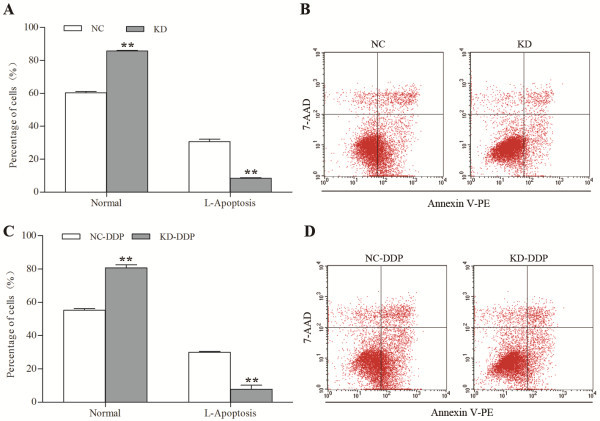
Effect of H19 knockdown on the apoptosis of JAR cells. A. Comparison of the percentages of normal cells and early apoptotic cells between the NC group and the KD group. H19 knockdown significantly increased the percentage of normal cells but decreased the percentage of early apoptotic cells when compared with the NC group; B. Flow cytometric analysis of JAR cells in the NC group and the KD group; C. Comparison of the percentages of normal cells and early apoptotic cells between the two groups with DDP treatment. H19 knockdown also significantly increased the percentage of normal cells but decreased the percentage of early apoptotic cells when compared with the NC-DDP group; D. Flow cytometric analysis of JAR cells in the NC-DDP group and the KD-DDP group. NC-DDP is the negative control vector-harboring cells incubated with DDP; KD-DDP, H19-RNAi-LV-3-infected cells incubated with DDP. ** denotes P < 0.01.